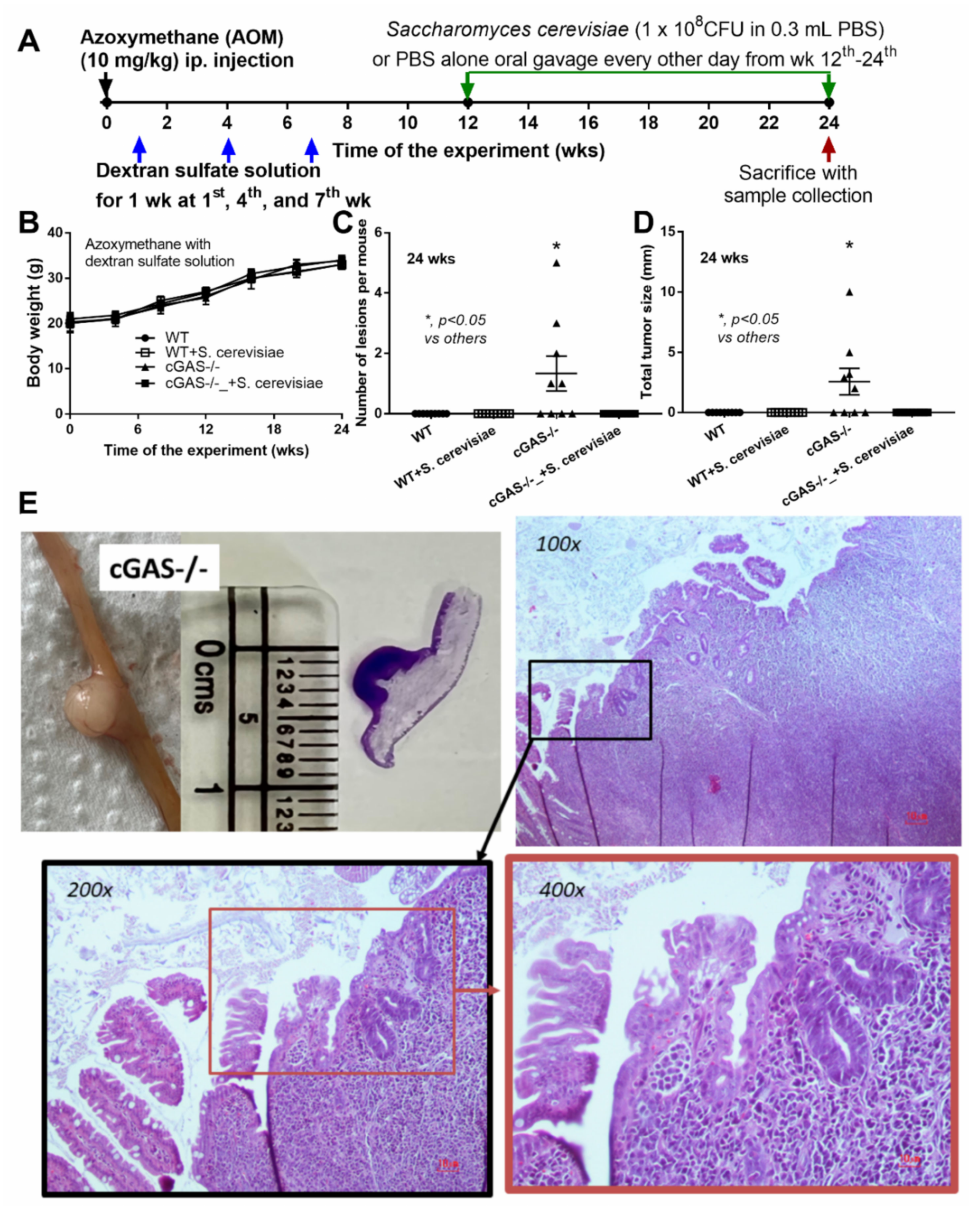
Figure 1. Schema of the experiments of azoxymethane (AOM) with dextran sulfate solution (DSS)- induced colon cancer and oral gavage of Saccharomyces cerevisiae or phosphate buffer solution (PBS) control in cGAS-deficient (cGAS-/-) and wild-type (WT) mice ( A ); characteristics of the mice as indicated by body weight ( B ), number of lesions ( C ), total tumor size (diameter of each polyp multi- plied by the number of polyps displaying this diameter) ( D ); a representation of the tumor by direct visual observation (from mice and histological slide with a scale in centimeters) ( E , left upper) and Hematoxylin and Eosin (H&E) staining from a polyp-liked lesion indicating the monomorphic bizarre cell morphology of the cancer lesion, with the original magnification at 100x–400x ( E , histological pictures) ( n = 9–10/group) (ip., intraperitoneal injection). The analysis of time-point data ( B ) and the multiple groups ( C , D ) were determined by repeated measures ANOVA and one-way analysis of variance (ANOVA) with Tukey’s analysis, respectively. The exact p values for ( C , D ) are demonstrated in Table